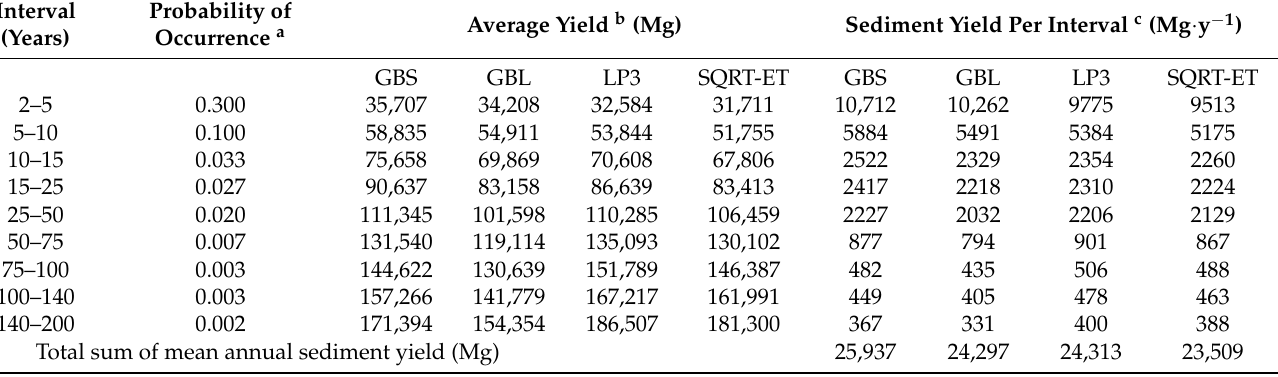
Table 5. Mean annual sediment yield estimation and comparative